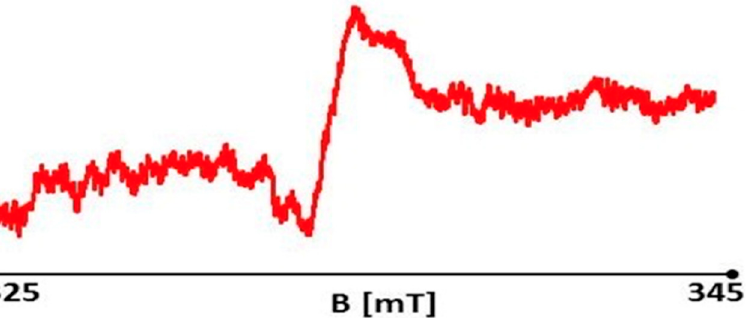
Figure 28. EPR spectrum of a burn wound on day 0 (control). Spectrum measurement was performed with 15 dB attenuation and 2.2 mW microwave power.